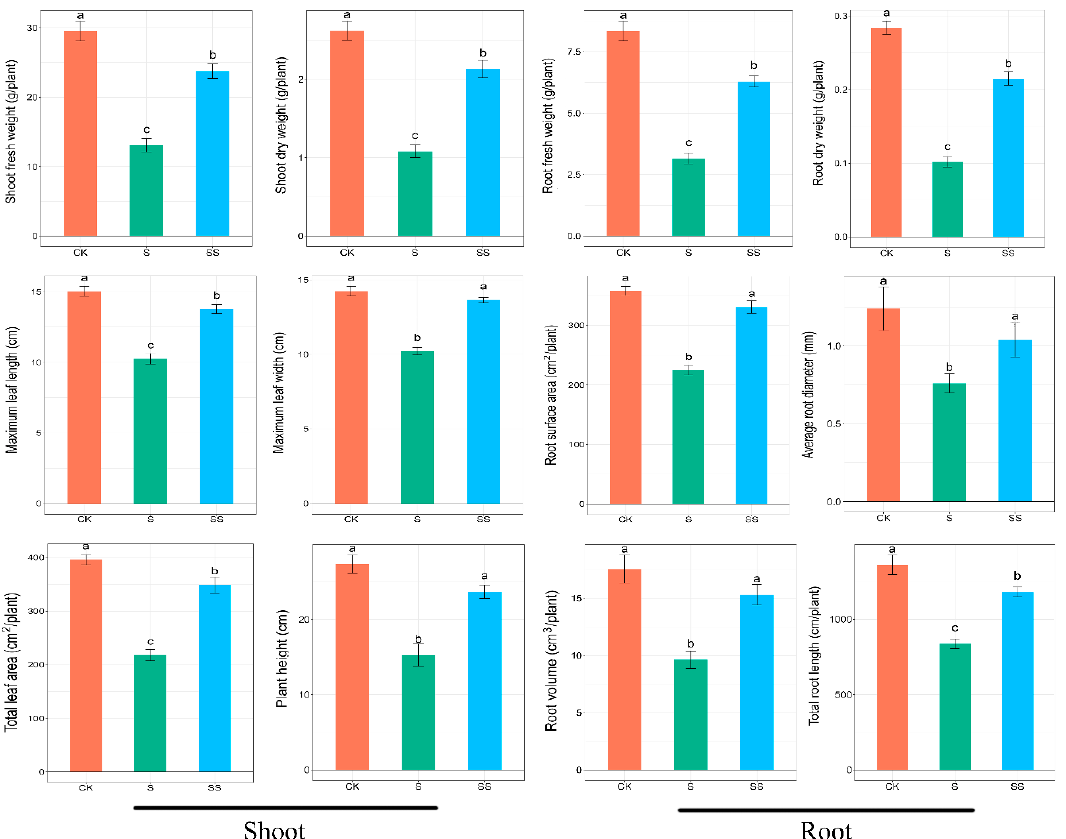
Figure 2. E ff ect of Spd on growth parameters of cucumber seedlings under salt stress. CK = control, Figure 2. Effect of Spd on growth parameters of cucumber seedlings under salt stress. CK=control, S= S = 75 mM NaCl, SS = 75 mM NaCl + 0.1 mM Spd. Data are expressed as the mean ± standard 75 mM NaCl, SS=75 mM NaCl + 0.1 mM Spd. Data are expressed as the mean ± standard error. error. Di ff erent letters indicate significant di ff erences at p < 0.05, according to Duncan’s new multiple Different letters indicate significant differences at p < 0.05, according to Duncan’s new multiple range range test.